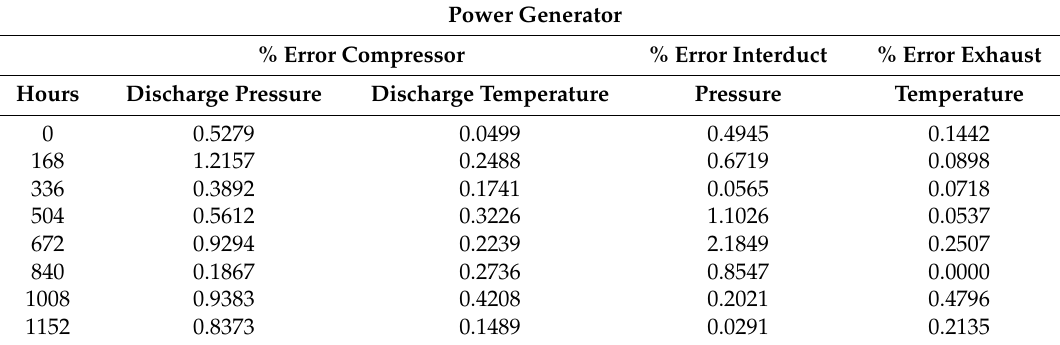
Table 2. Error between measured and simulated data at high power operation (power generator).